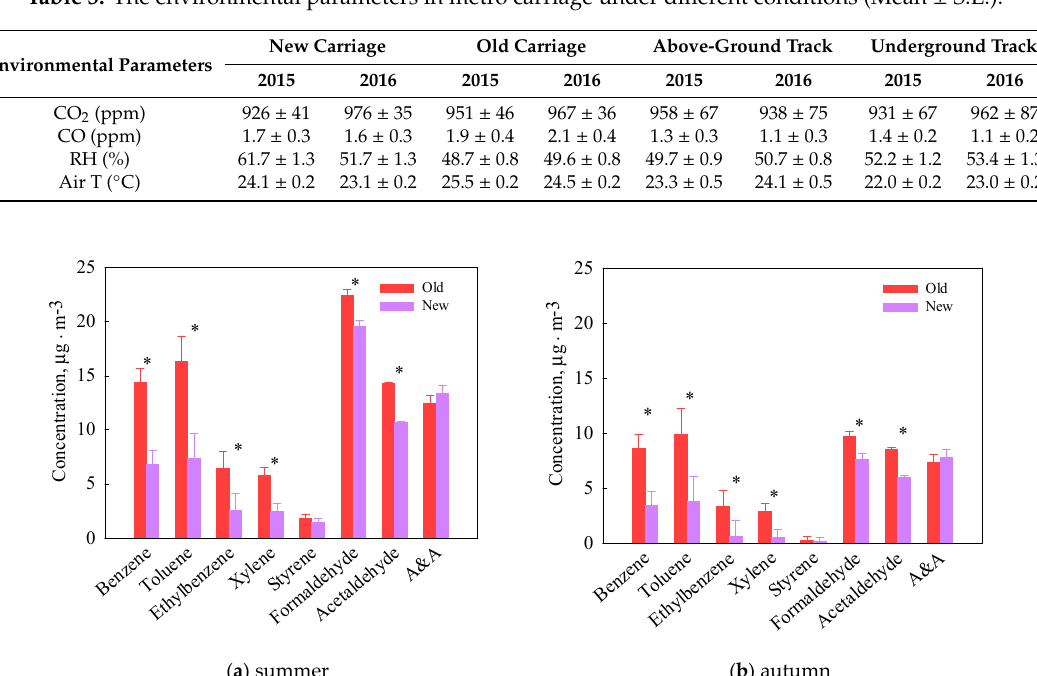
paints are used in new trains while solvent-borne paints are used in old metro trains, which can emit more VOCs. Second, different air filtration methods are used in different metro lines, which may also contribute to the significant differences of VOCs concentration between old and new metro trains. Stainless steel wire mesh is used in old metro trains, while the new metro trains use fibrous air filter, of which filtration efficiency is higher. Additionally, we found that the concentration of VOCs in metro carriage during the summer were ~90% higher than that during the autumn regardless of